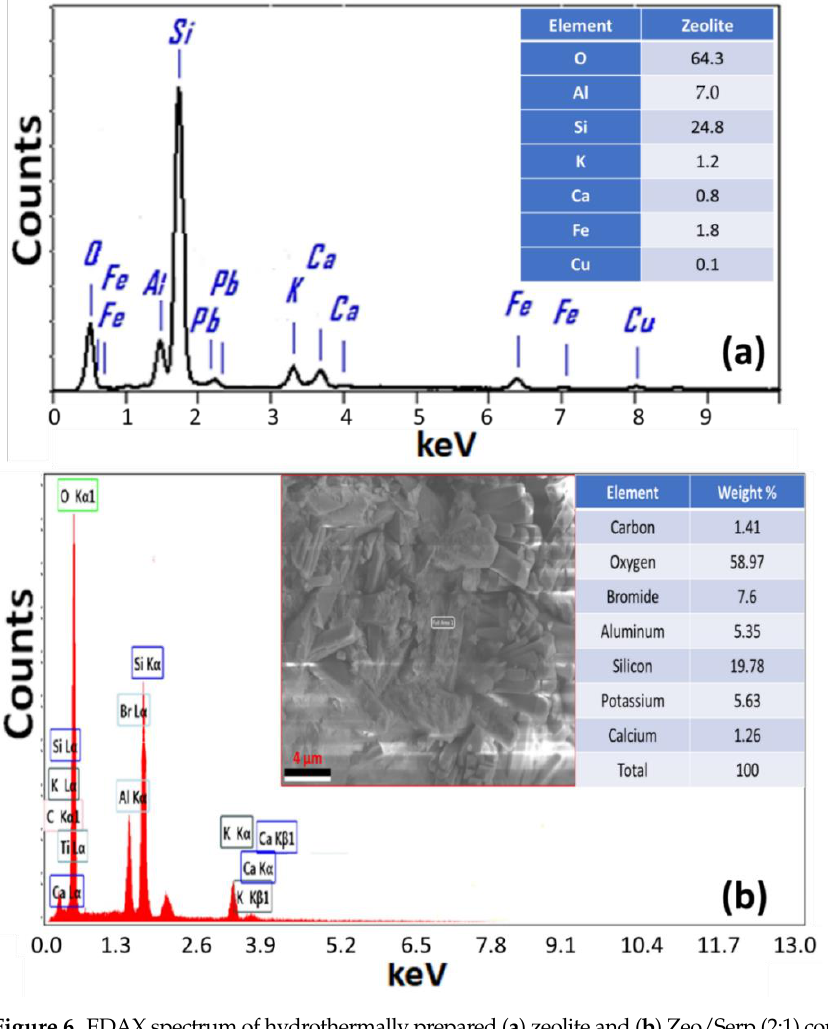
Figure 6. EDAX spectrum of hydrothermally prepared ( a ) zeolite and ( b ) Zeo/Serp (2:1) composite sample.